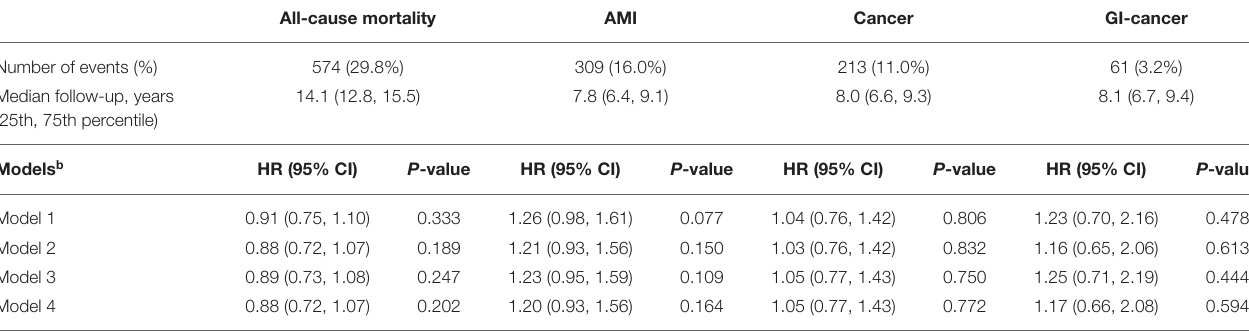
TABLE 3 | The association between energy-adjusted total meat intake and clinical endpoints—results from the Cox proportional hazard regression model a . All-cause mortality AMI Cancer